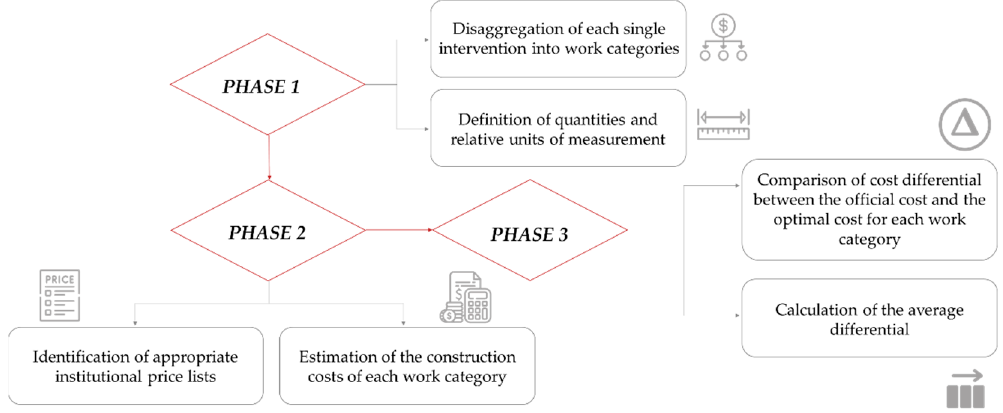
Figure 2. Computational phase articulation of the assessment method.